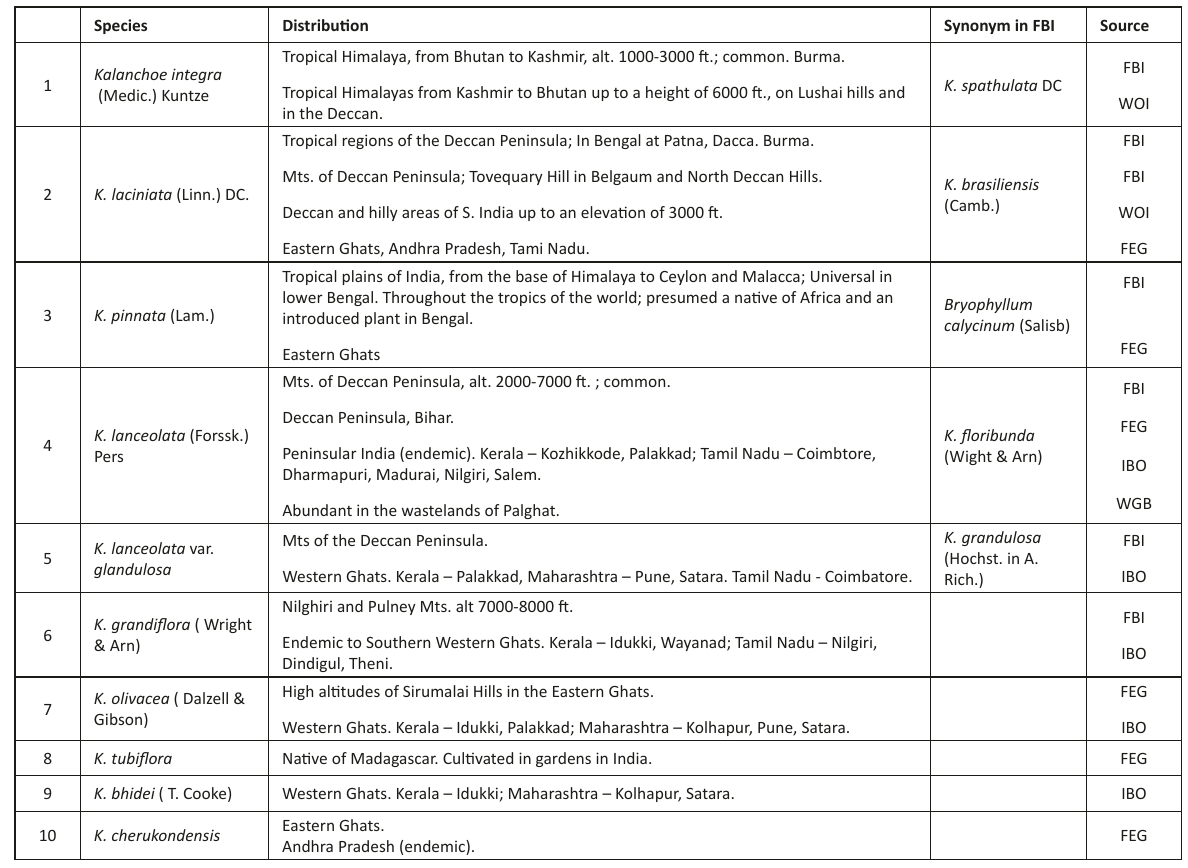
Table 2. Distribution of Kalanchoe spp. in India Species